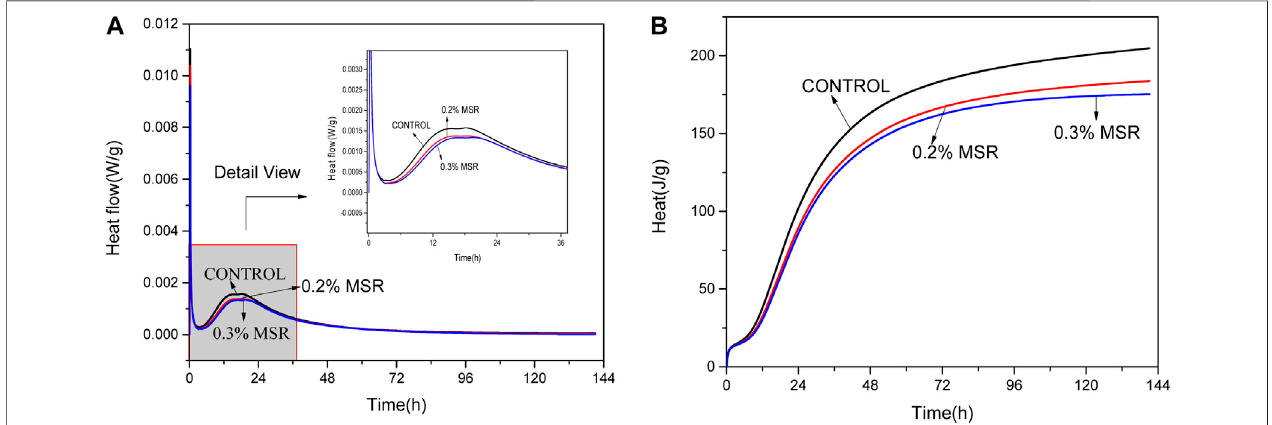
FIGURE 8 | Microcalorimetric curve of cement paste with 0.4 W/C under the constant test temperature of 20 ° C showing (A) heat fl ow rate and (B) cumulative hydration heat.